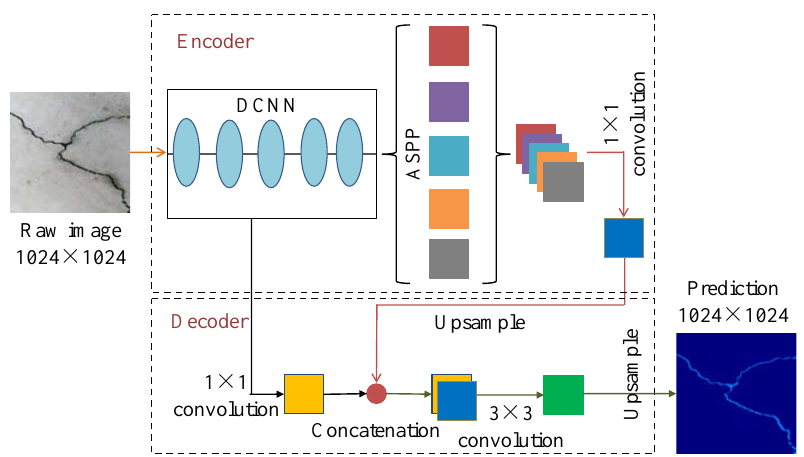
Figure 3. The DeepLab_v3+ network.